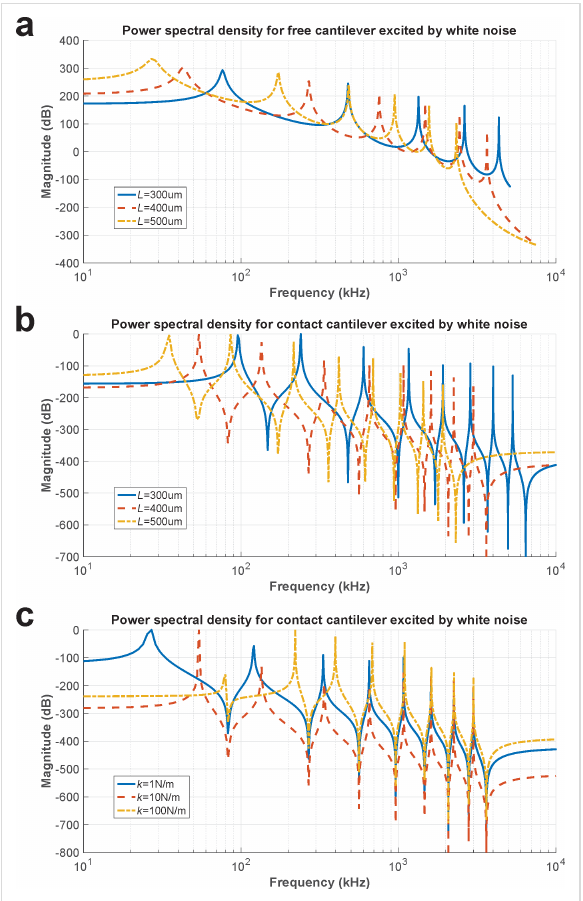
Figure 4: PSD simulation. a) Free cantilever: L = 300 μ m(blue line), L = 400 μ m (dashed red line) and L = 500 μ m (dotted yellow line); b) cantilever in contact: L = 300 μ m (blue line), L = 400 μ m (dashed red line) and L = 500 μ m (dotted yellow line); c) cantilever in contact for L = 400 μ m: = 1 N/m (blue line), = 10 N/m (dashed red line), = 100 N/m (dotted yellow line).